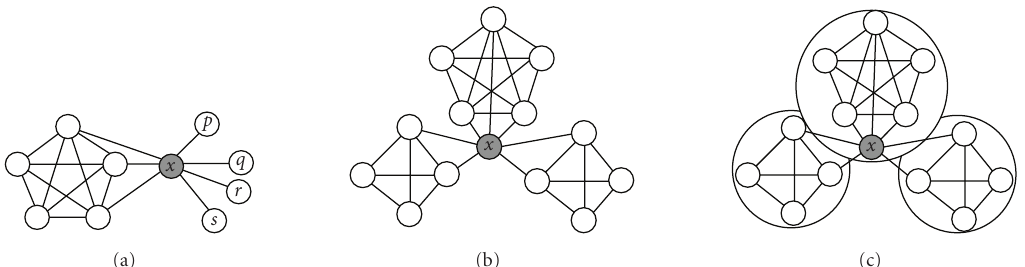
Figure 2: (a) After removing nodes p , q , r , and s and their edges, node x forms a near-clique of type A with the remaining nodes. (b) This graph becomes a near-clique G of type C since indegree( x , G ) ≥ 0 . 5 | G | . (c) A big near-clique is too big (e.g., near-clique with more than 50 nodes) and is split into smaller near-cliques (in this example, 3 small